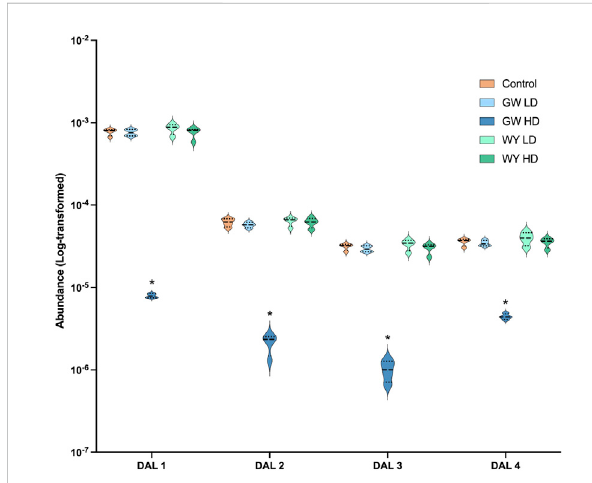
Changes in signi fi cantly affected lipids in Atlantic cod whole liver tissue following exposure to WY-14,643 and GW501516. The levels of differentially abundant lipids (DALs) were measured using untargeted UPLC-HDMS lipidomics (see Supplementary Table S4 for DAL ID characterization). Lipid compounds signi fi cantly (adjusted p < 0.05) affected by the exposures were identi fi ed using “ limma ” and are indicated by an asterisk (*). Violin plots with median (solid line) and quartiles (dotted lines) indicated were produced in GraphPad PRISM v.9.